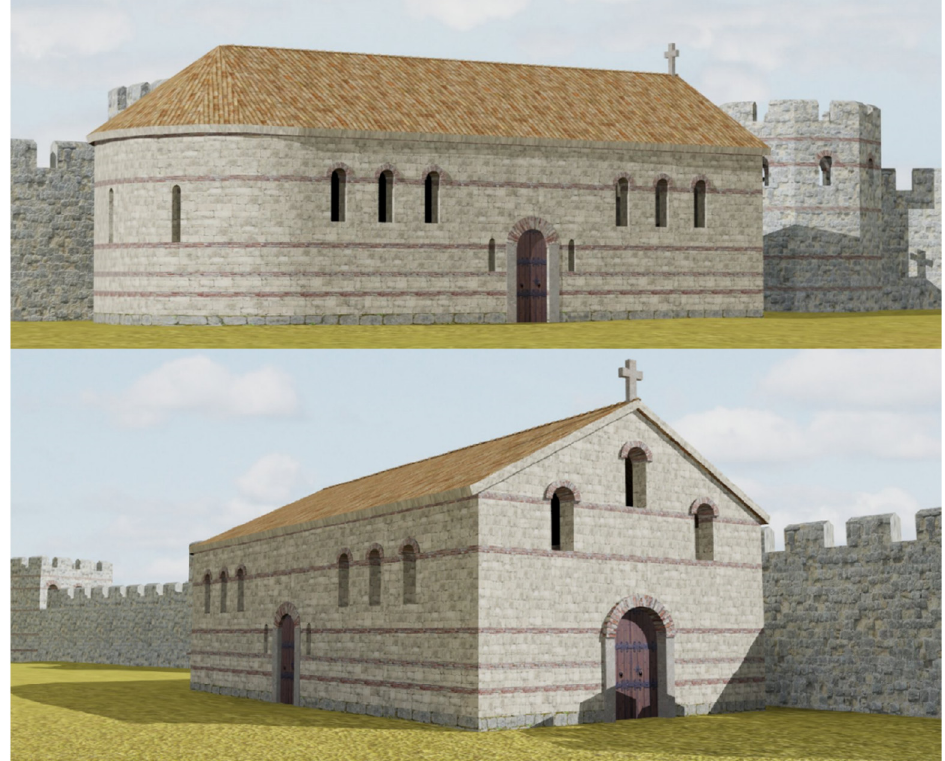
Figure 13. Reconstruction of the appearance of the Church No. 1.